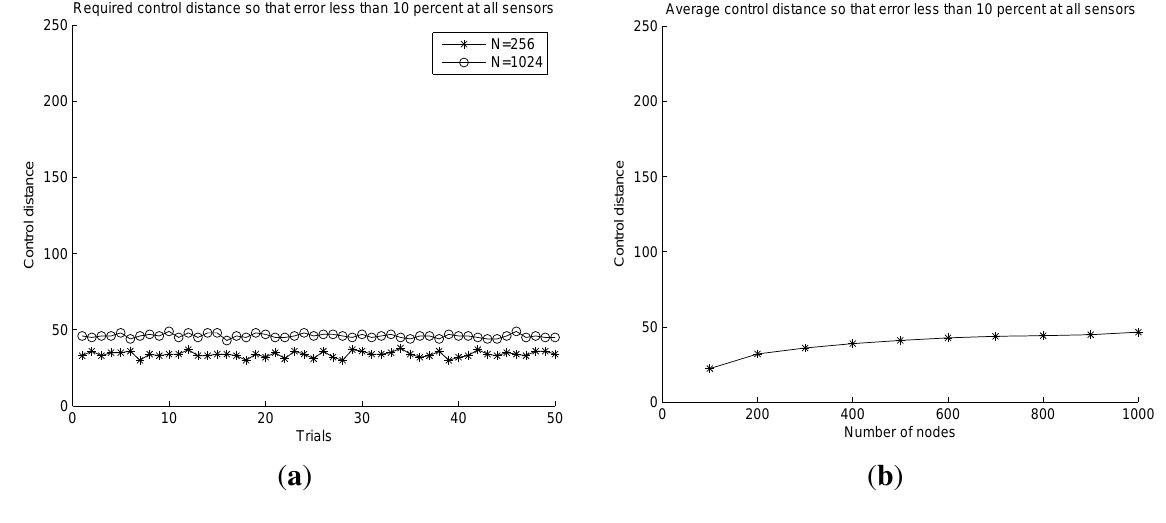
Figure 5. ( a ) Required control distance so that error across all sensors is less than 10% across 10 trials in a 256 node network and 1 , 024 node network; ( b ) required control distance so that error across all sensors is less than 10% , as a function of network